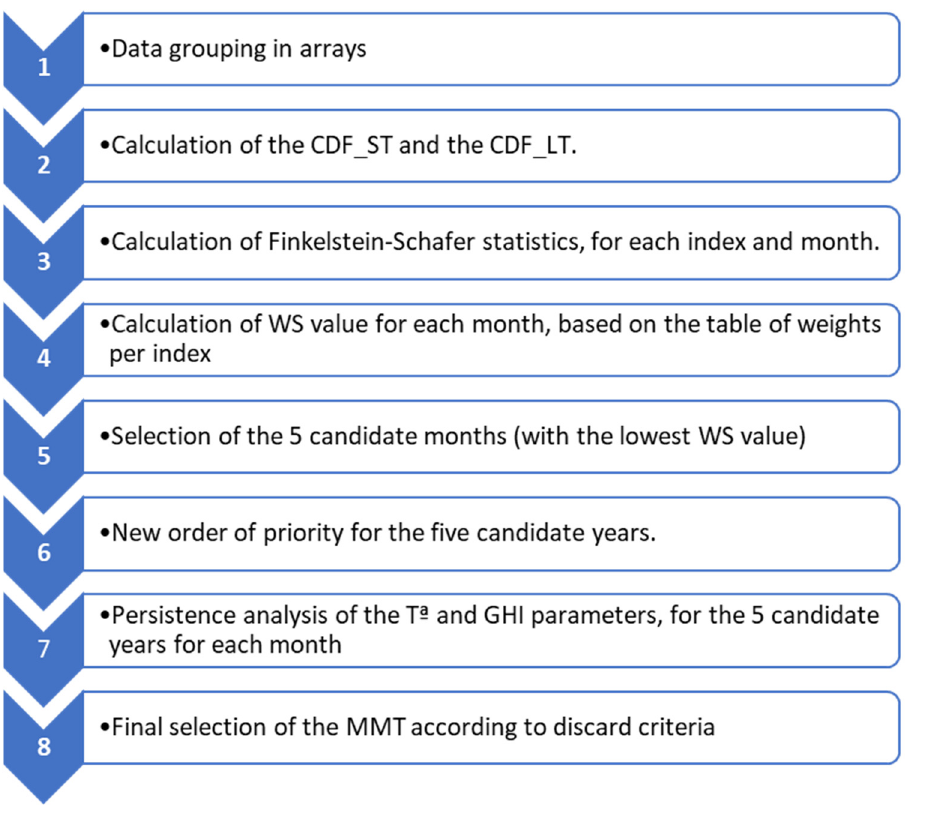
Figure 2. Flowchart of the selection process for the 12 TMM according to Sandia method.